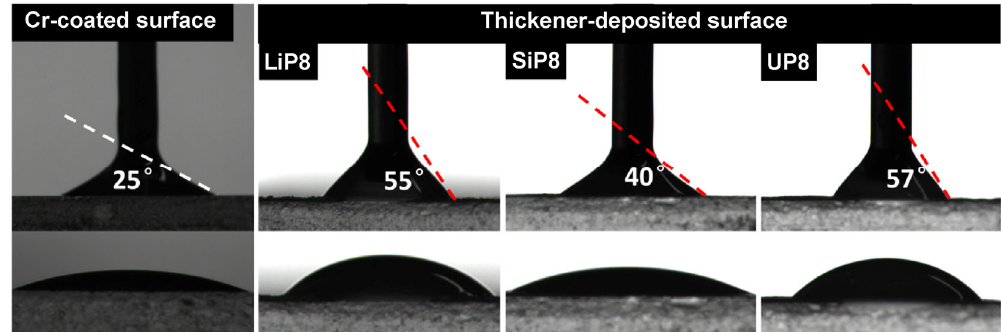
Fig. 6 Contact angle of PAO8 both on the chromium-coated surface and thickener-deposited